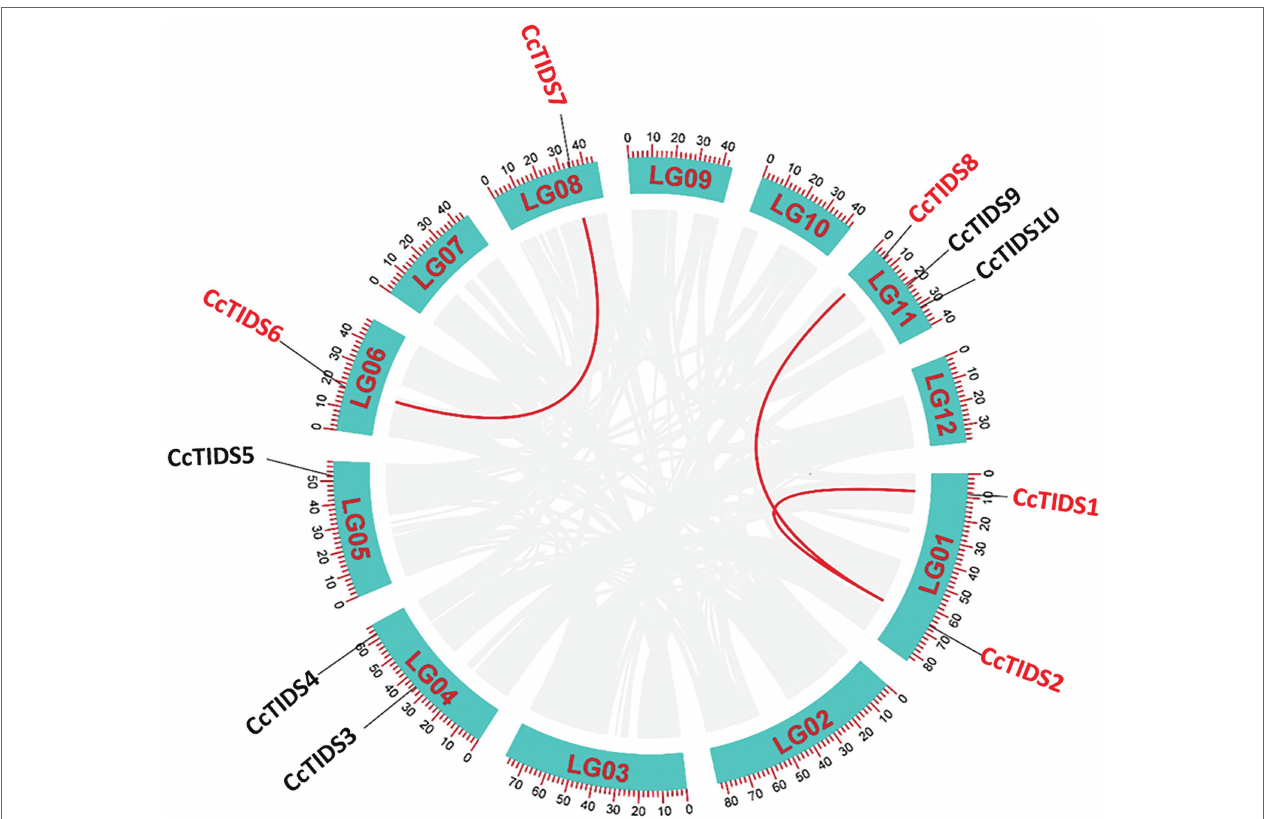
FIGURE 1 | Circos graph showing the chromosomal locations and duplicated gene pairs of trans-isopentenyl diphosphate synthases ( CcTIDS ) genes in the C. camphora genome. The blue segments represent the 12 chromosomes present in this species. Duplicated genes are indicated as red lines between each gene